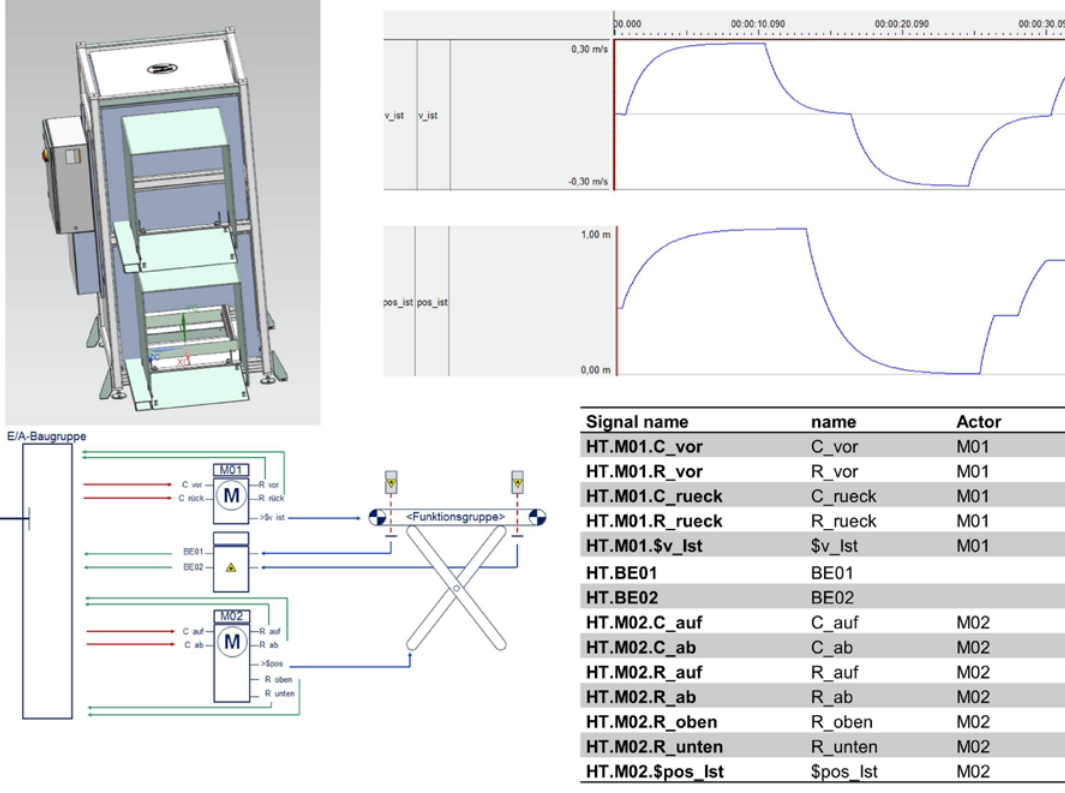
Figure 8. CAD model, behavior model, schematic diagram, and signal list of a module of the construction kit (conveyor belt